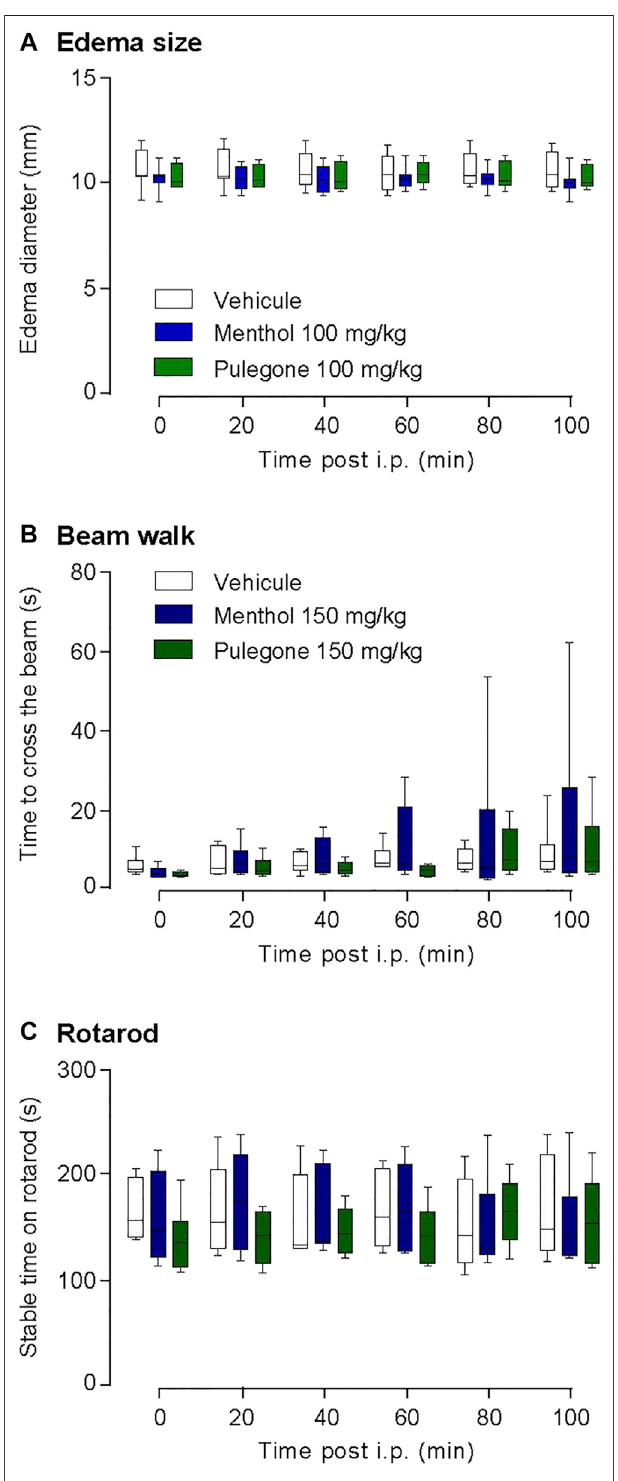
FIGURE 5 | Control of terpenes effect on edema and locomotor activity. (A) Time-course of the effects of i.p. menthol 100 mg/kg ( n (cid:1) 8), pulegone FIGURE5 |Pulegone(150 mg/kg), n (cid:1) 6)tested withthe (B) rotarod two-way 100 mg/kg( n (cid:1) 8),orthevehicle( n (cid:1) 8)onCFA-inducededemasize(two-way ANOVAF(5;75) (cid:1) 0.2535, p (cid:1) 0.9367andthe (C) beam walktwo-way ANOVA ANOVA F(5;75) (cid:1) 1.643, p (cid:1) 0.1526). Time-course of the locomotor F(5;75) (cid:1) 3.34, p (cid:1) 0.089. Data are expressed as mean ± SD. No statistical activity after an i.p. injection (Vehicle, n (cid:1) 6; Menthol (150 mg/kg), n (cid:1) 6; signi fi cance was observed, using two-way ANOVA followed by Dunnett ( Continued ) multiple comparisons post-hoc